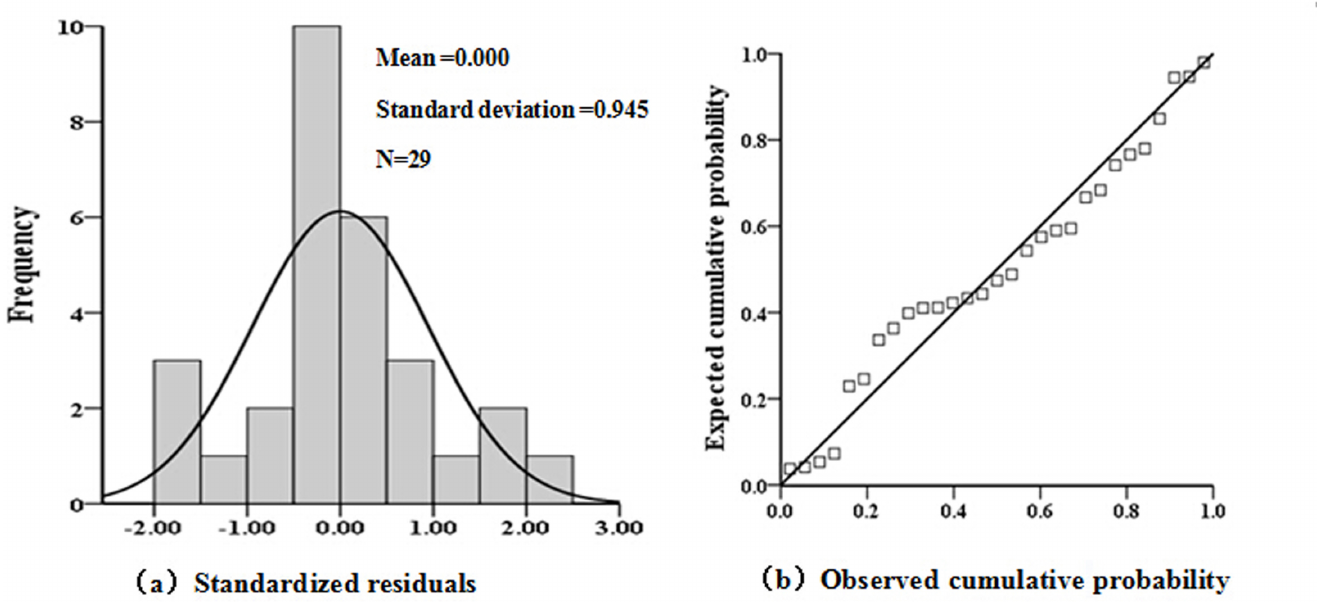
Fig 4. The histogram of standardized residuals (a) and the normal probability plot of standardized residuals